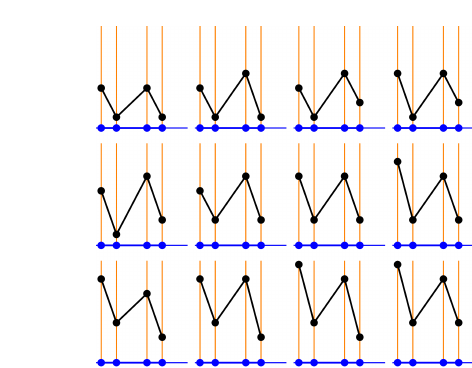
Figure 3. The complete set of cross-sections for the case of p = 3 (corresponding to the third graph in the top row of Figure 2). The leftmost cross-section is considered the base cross-section and is obtained directly from G 3 . The complete set of cross-sections is obtained from the base cross-section via unit increase progression starting on the first fiber to the right of the midpoint. Each cross-section directly gives the 4 p numerical values in the centered polygonal lacunary sequence at the position on the natural boundary at angle α 3